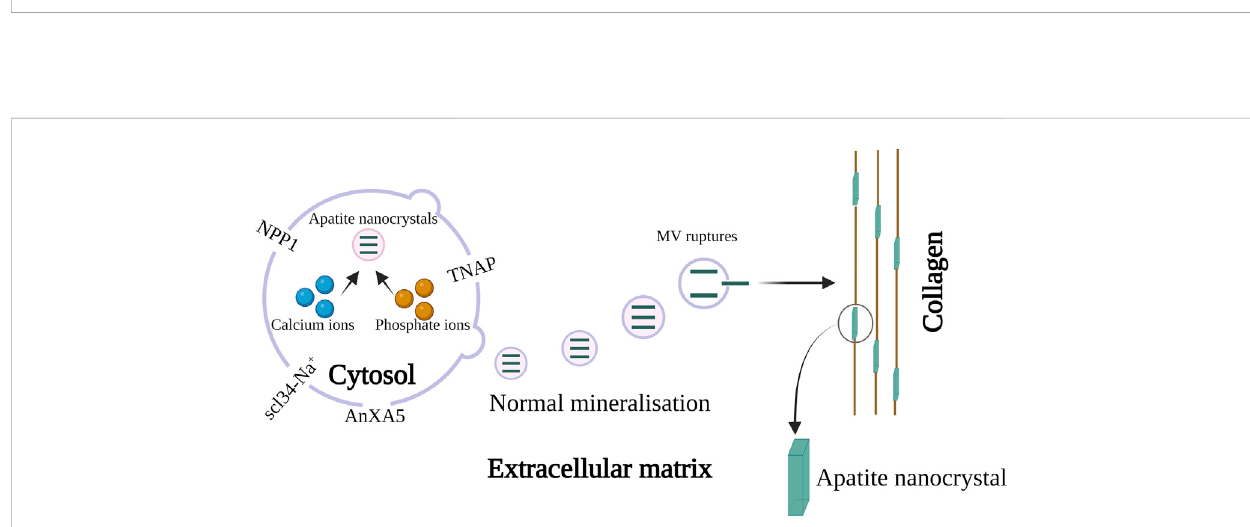
FIGURE 5 SchematicrepresentationofMVinbiomineralization.ThebiomineralizationbyMVoccursintwosteps,instep1apatitenanocrystalisformed via the in fl ux of calcium and phosphate ions through AnXA5. The hydrolytic action of the enzyme phospholipase and the protease leads to the penetration of apatite crystal inside MV. Once the MV is released into the extracellular matrix they bind to collagen. This initiates step 2 resulting in biomineralization in presence of collagen. The image is inspired by the artwork of (Bottini et al., 2018) and (Bommanavar et al.,